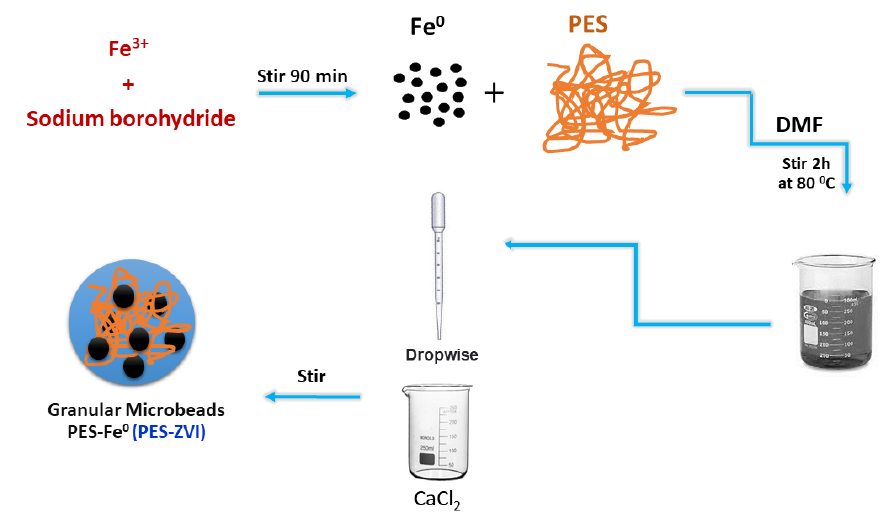
Figure 1. Schematic route for the synthesis of PES-Fe 0 beads (PES-ZVI).